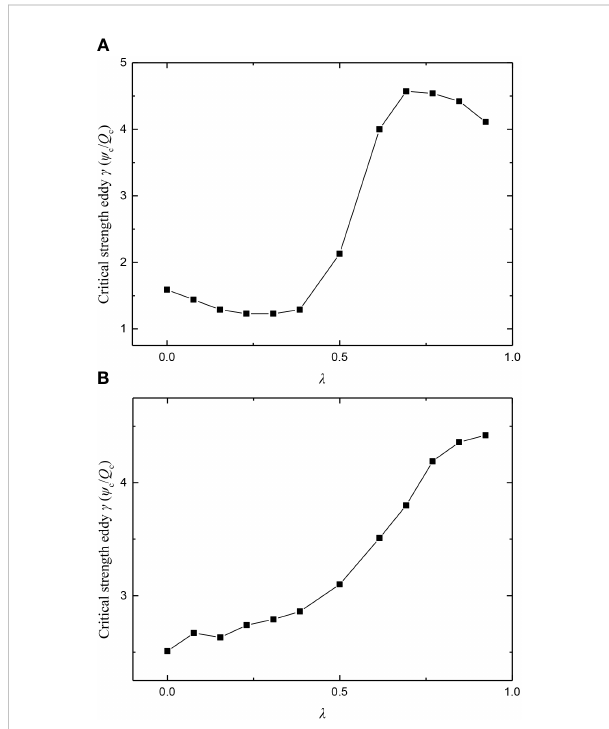
FIGURE 13 The dimensionless critical strength ( g ) of the cyclonic eddy (A) and the anticyclonic eddy (B) inducing the critical WBC transition from the leaping to penetrating regime as a function of l . WBC, western boundary